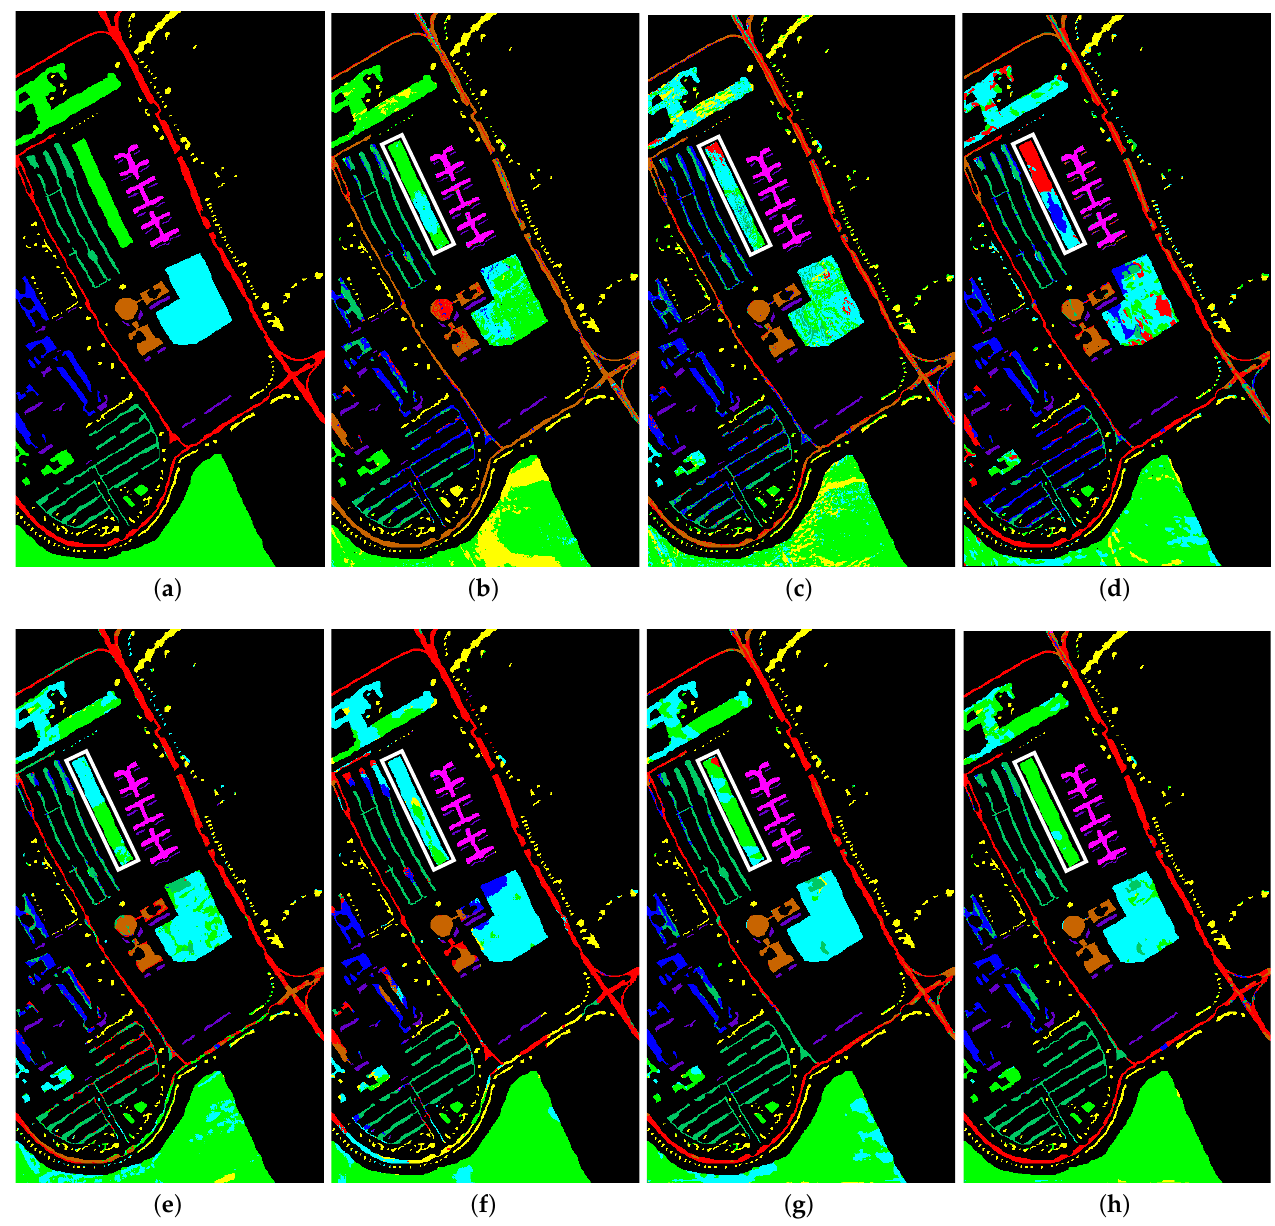
Figure 8. Graph of classification results of UP dataset. Similar to Figure 7, the highlighted white box in each subfigure is used to compare the classification results more clearly. ( a ) Ground truth (GT). ( b